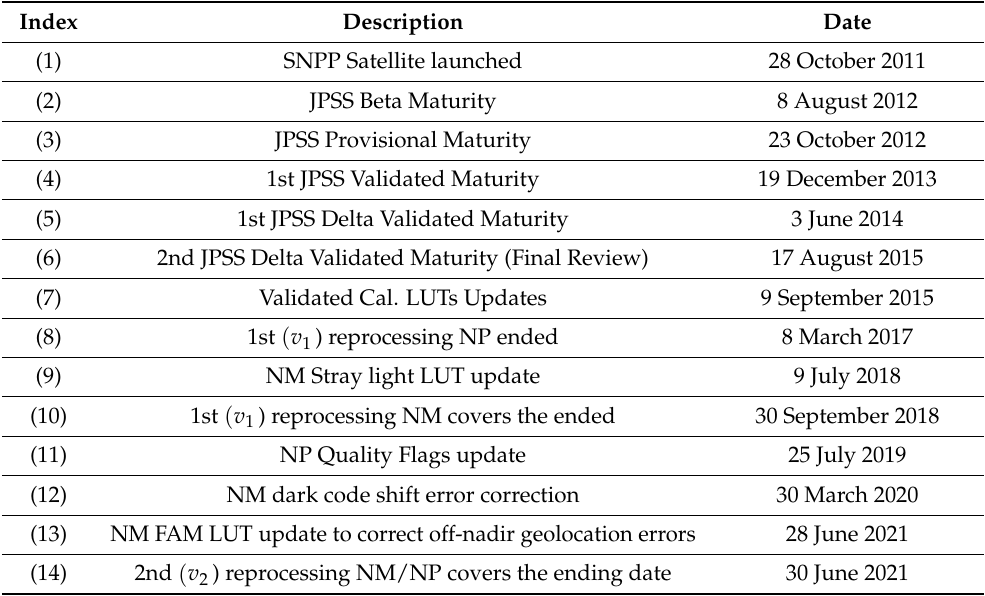
Table 3. The JPSS reviews, major improvements, and events in the SNPP OMPS SDR calibra- tion/validation